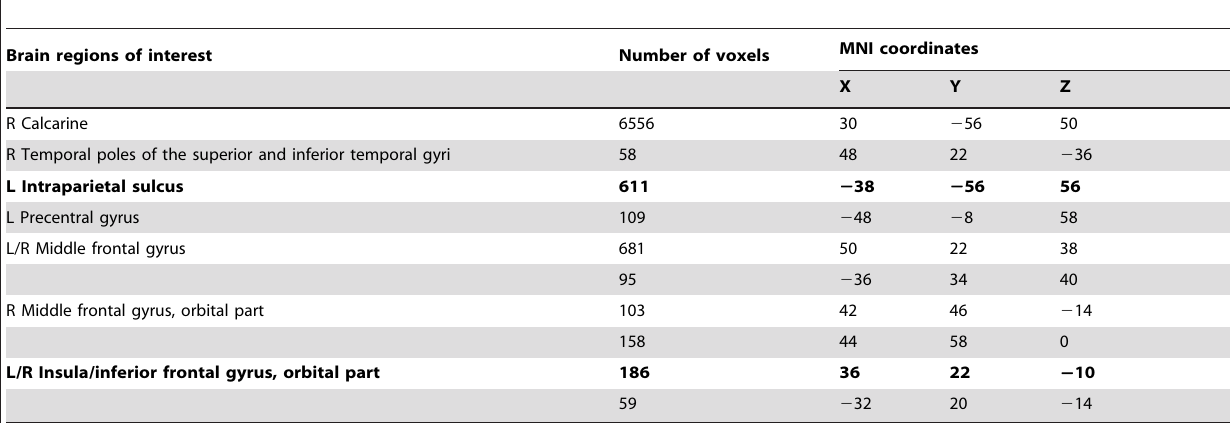
Table 1. MNI coordinates and number of voxels of brain regions more activated in children who succeeded to the length- interference items than in children who were not able to efficiently perform the Piagetian